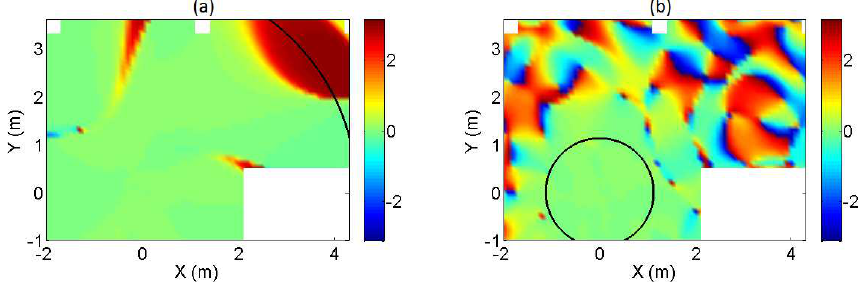
Figure 11. Phase error of the reference room at 63 Hz ( a ) and 250 Hz ( b ), regularized β =